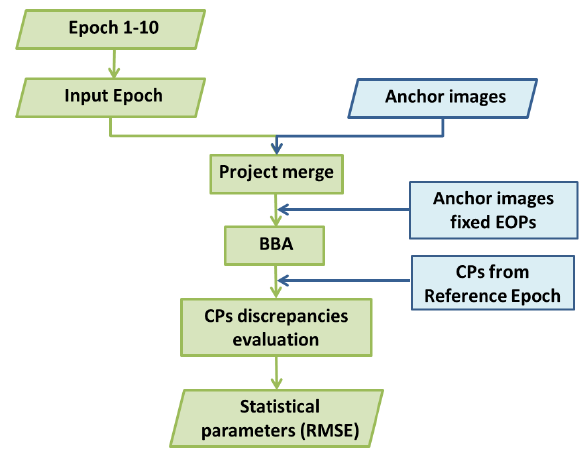
Figure 4. Workflow of the RIBC